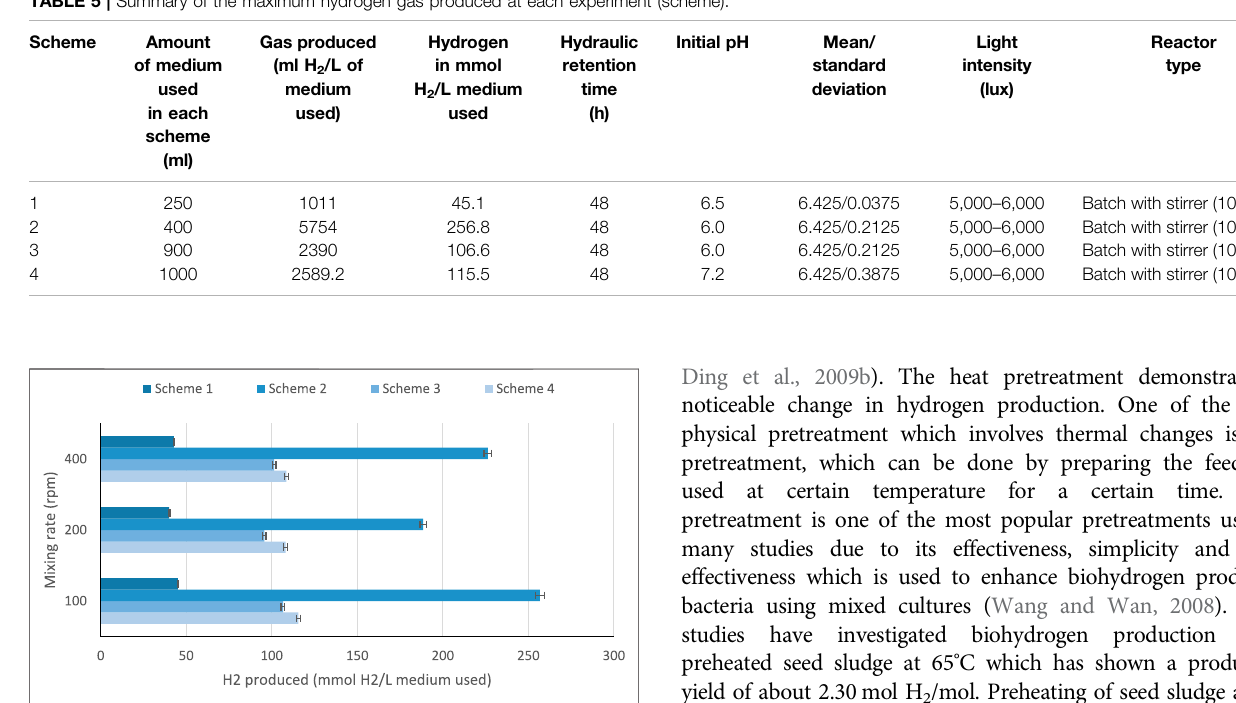
FIGURE 4 | Effect of heat pretreatment, pH, and mixing rate on hydrogen